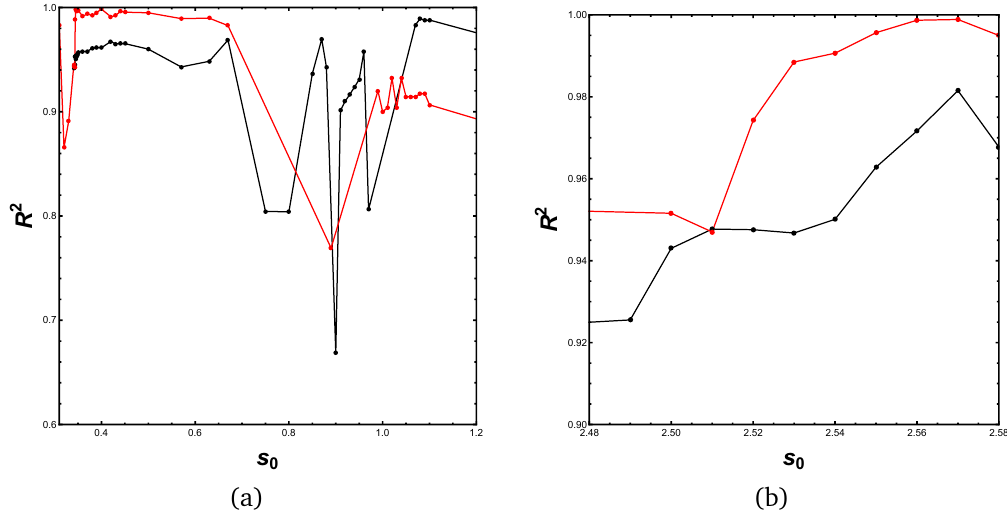
Figure 3: (a) Region A : Plot of R 2 vs s 0 of even(Black) and odd(red) trajectories for upper boundary near Region A. We have good linearity when R 2 (coefficient of determination) is closer to 1. (b) Region B : Plot of R 2 vs s 0 of even(Black) and odd(Red) trajectories for upper boundary near Region